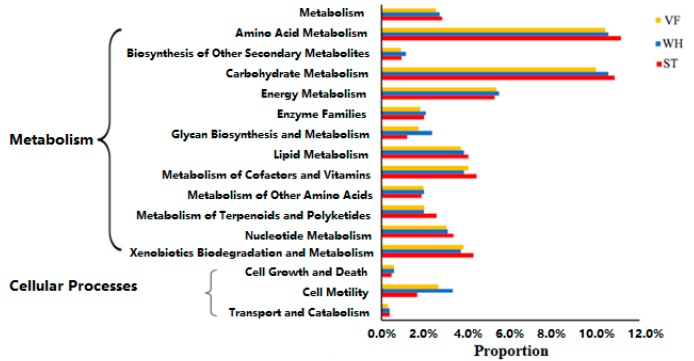
Figure 9. Phylogenetic investigation of communities by Reconstruction of Unobserved States (PICRUSt), predicting functional profile alteration of microbial communities enriched in VF, WH, and ST.